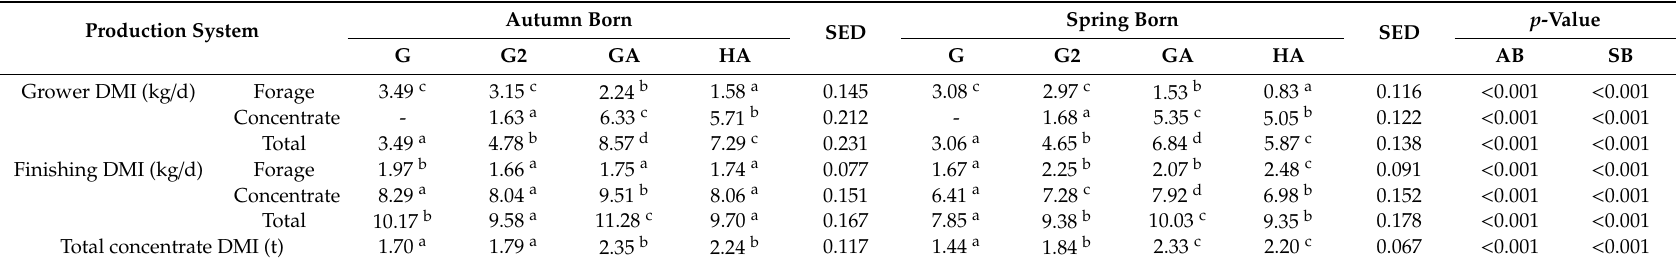
Table 3. Mean estimated dry matter intakes during the grower and finishing period for autumn and spring born bulls on four production systems.